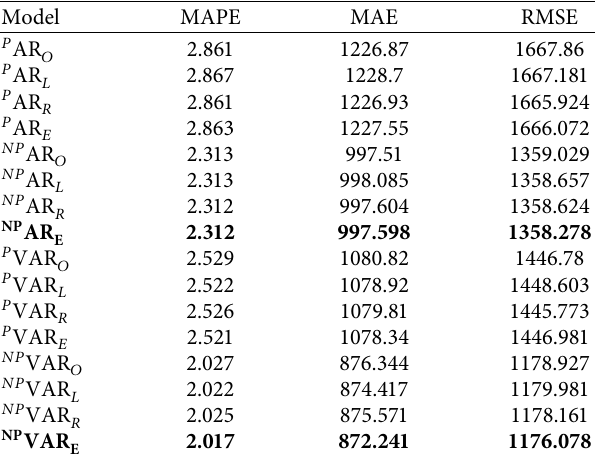
Table 1: Nord Pool electricity demand: one-day-ahead out-of- sample forecasting errors.